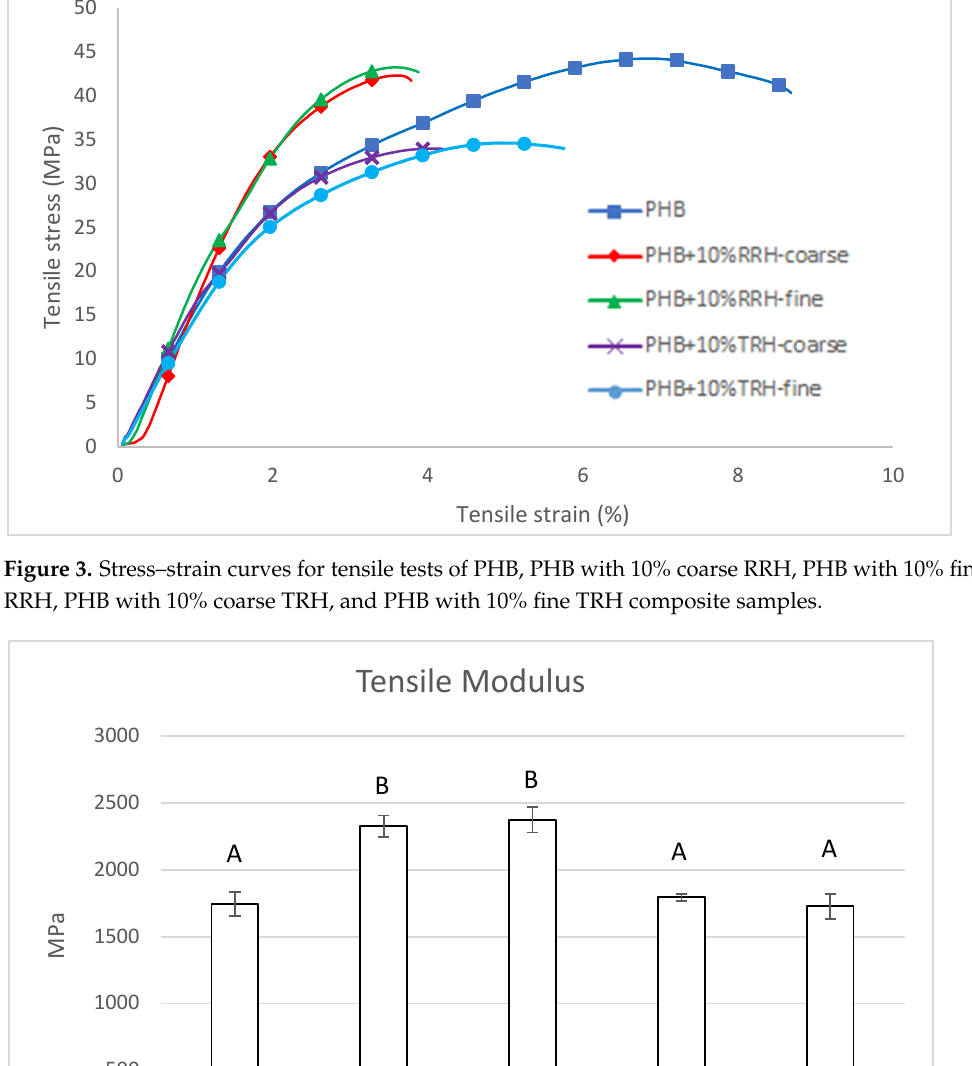
Figure 3. Stress–strain curves for tensile tests of PHB, PHB with 10% coarse RRH, PHB with 10% fine RRH, PHB with 10% coarse TRH, and PHB with 10% fine TRH composite samples.